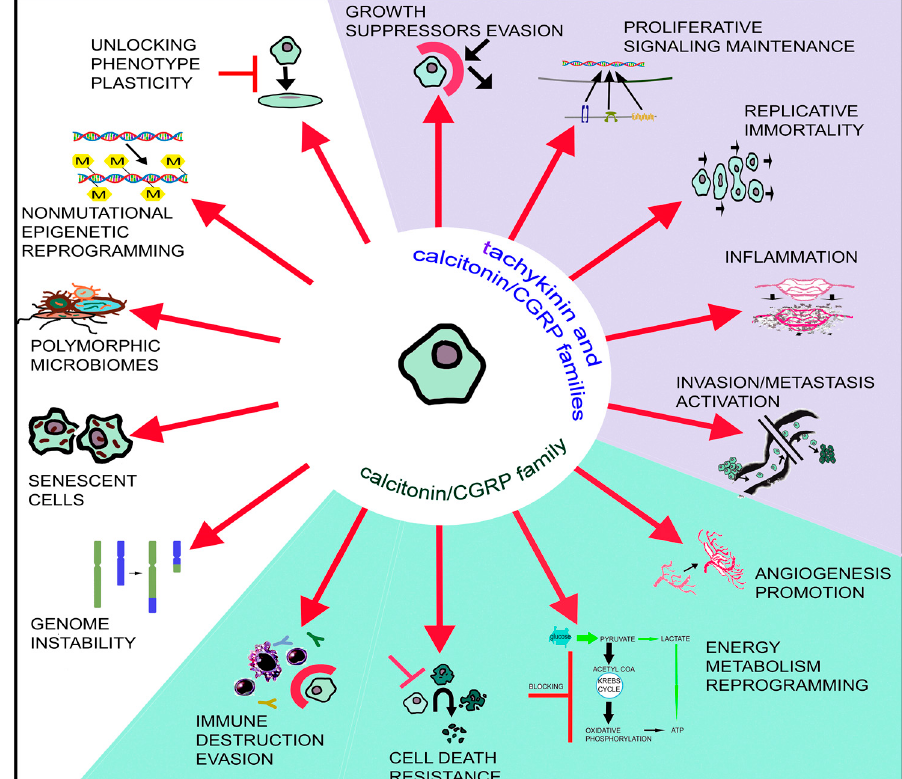
Figure 1. The 14 hallmarks currently considered to be responsible for the development of cancer are indicated. Five hallmarks (blue background) are mediated by peptides belonging to the tachykinin and calcitonin/CGRP peptide families, and four hallmarks (green background) are mediated by peptides belonging to the calcitonin/CGRP peptide family.